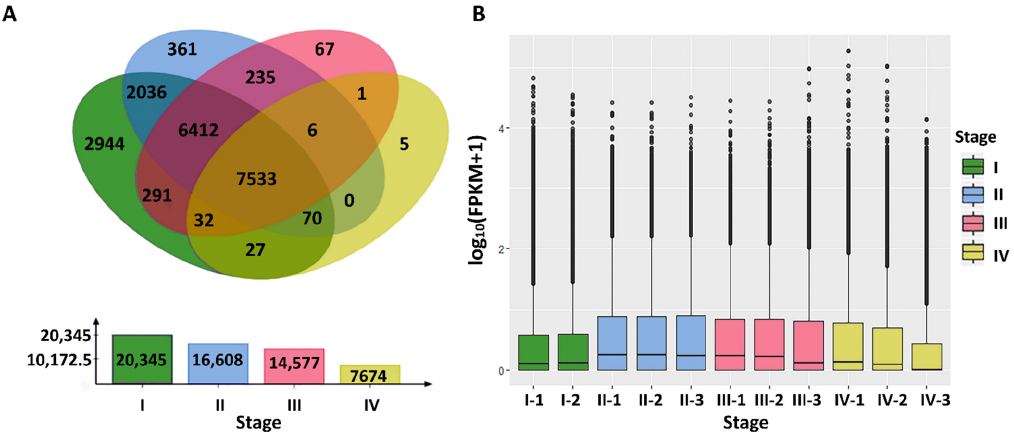
Figure 2. Statistical analysis of the transcriptome sequencing data. ( A ) Gene expression numbers of the four fish scale developmental stages. ( B ) Distribution of gene expression levels for each sample. The X-axis represents the sample name and the Y-axis represents the value of log 10 (FPKM + 1). The box chart of each part corresponds to the following from top to bottom: upper quartile, median, lower quartile, and lower limit. The upper and lower limits do not take outliers into account.